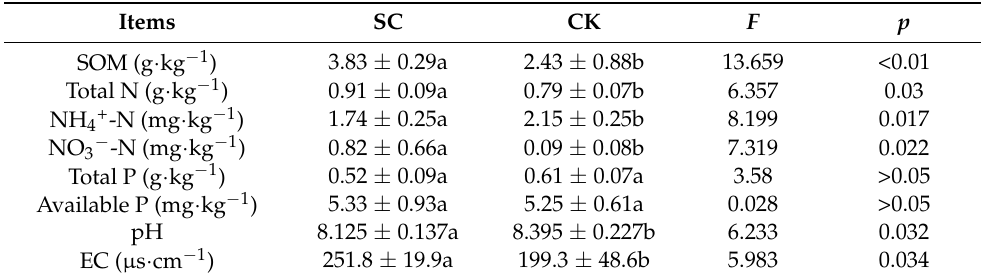
Table 1. Soil nutrients, pH, EC, and moisture of samples ( n = 6).